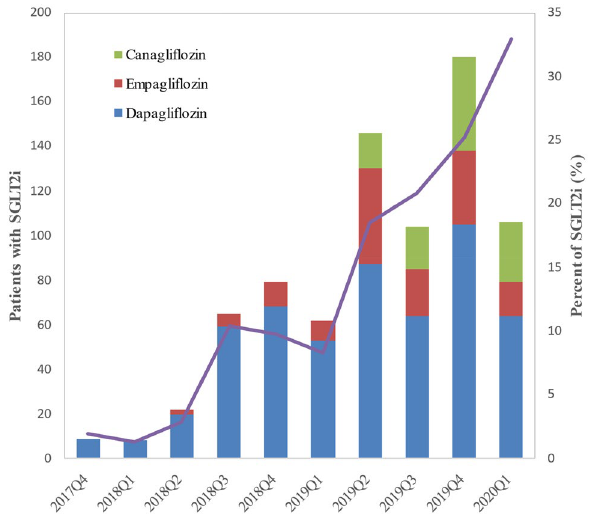
Figure 2. Time trends in proportion using SGLT2i and individual SGLT2i in study population. The stacked bar graphs represent the number of patients using dapagliflozin, empagliflozin and canagliflozin per quarter and the broken line represents the change trend of the overall relative DKD patients using SGLT2i over